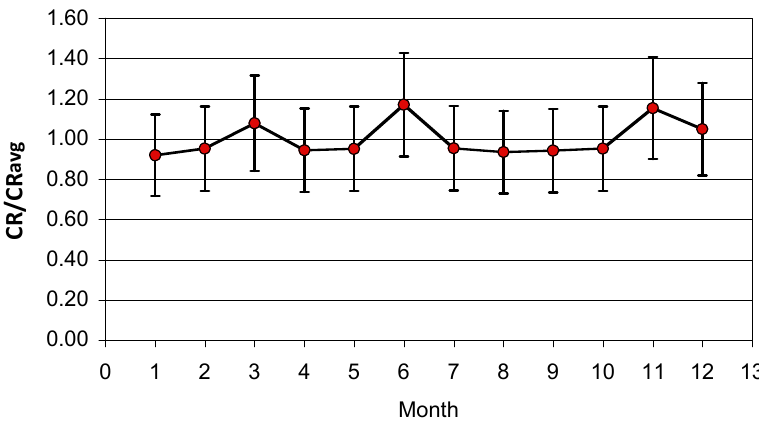
Figure 12. Relative concentration reductions (CR) over the course of the year for six steady flow large P wetlands (OEW, Boney, Titusville, ENRP, Lakeland, Shannon). Data have been normalized by the long-term mean CR for each wetland. Error bars are the average standard deviation for all months.